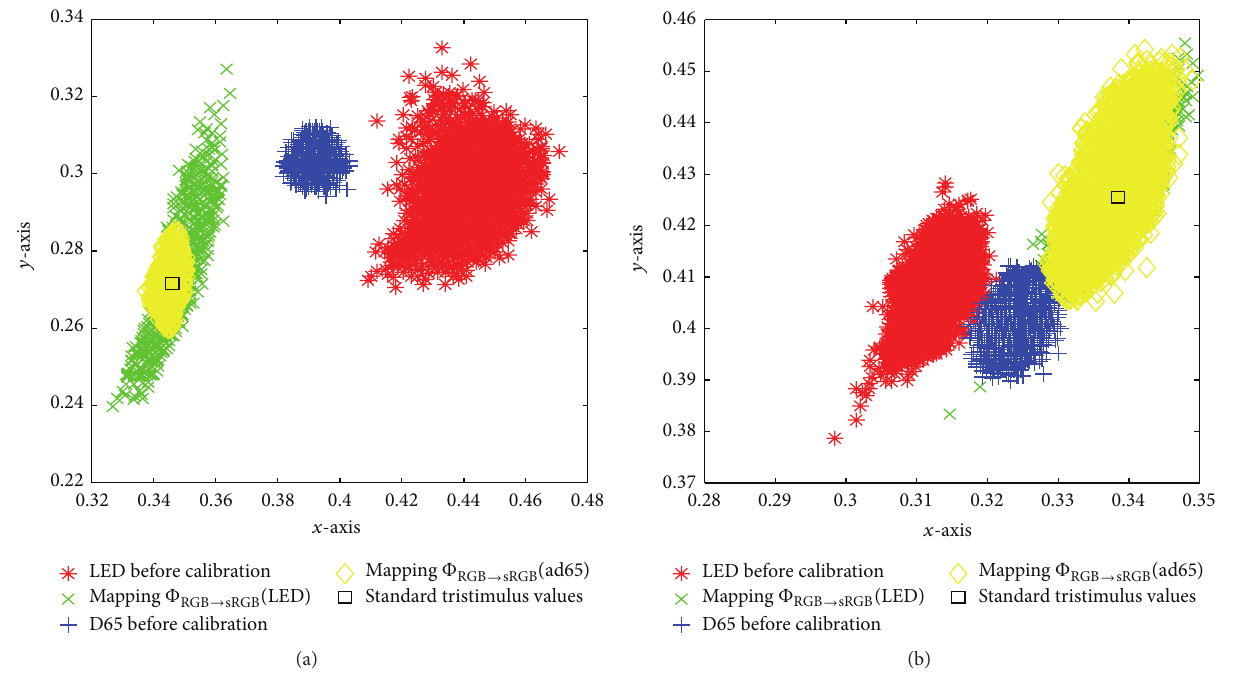
Figure 8: Chromaticity diagram 𝑥 - 𝑦 before and after calibration. (a) 225 M color patch and (b) 368 M color patch.